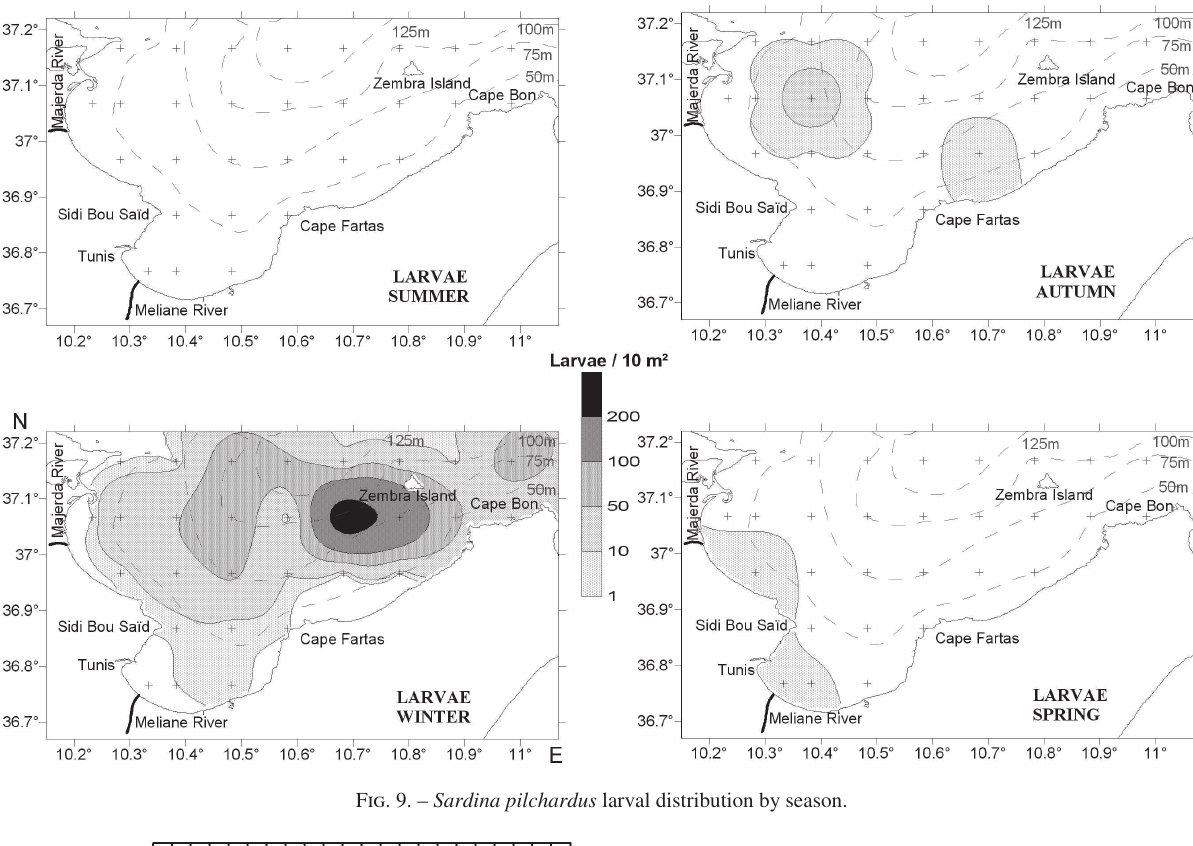
Fig. 9. – Sardina pilchardus larval distribution by season.